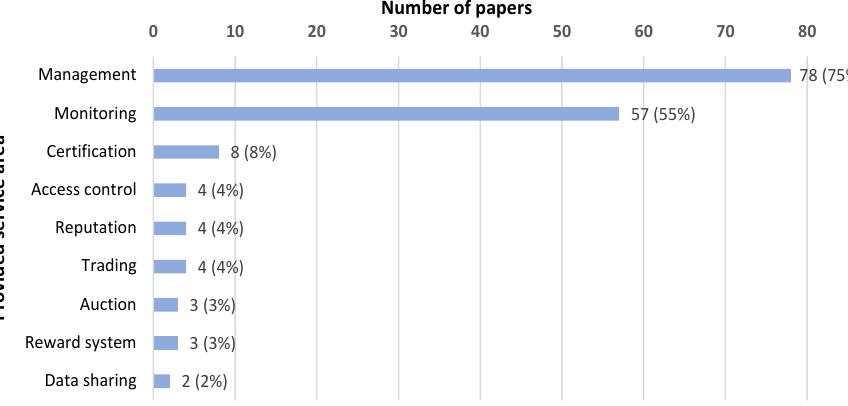
Figure 5. Service areas addressed in the papers included in our scoping